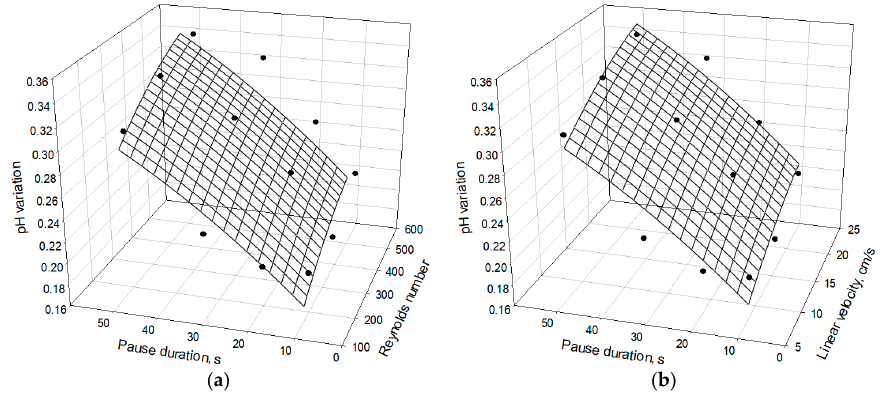
Figure 3. pH changes in the stream of caseinate solution during EDBM under PEF processes, each of which consumes 90 C of electricity, at different pause lapse durations (in s) and flow rates (expressed in: ( a ) Reynolds numbers and ( b ) linear velocity, cm/s). Reynolds numbers of 187, 374 and 560 correspond to linear velocities of 7.8, 15.6 and 23.4 cm/s, respectively. The pH value in the initial caseinate solution was 6.47 ± 0.02.